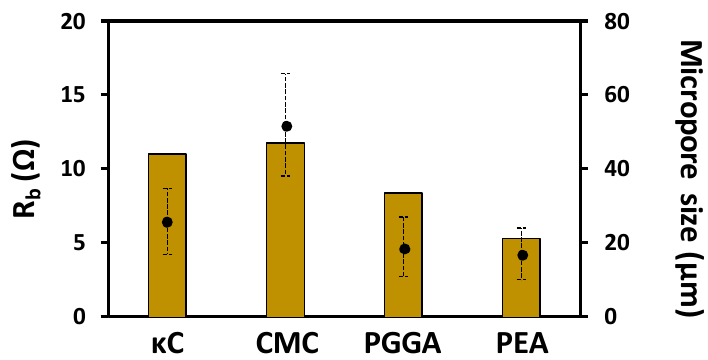
Figure 7. Relationship between pore size and the internal resistance for each of the hydrogel systems. The EEC used to fit the experimental EIS results for CMC, PGGA and PEA corresponds to the Randles-type electrical equivalent circuit [47]. In addition to R S and R P , the diagram shows two additional elements: (1) the capacitance C of the hydrogel in parallel with R P ; and (2) the constant phase element (CPE), which is associated with the capacitance of the electrical double layer (C dl ) on the electrode surface, in series with R P . In the case of κ C, the CPE is in parallel with resistance and, in addition, it shows a tangent hyperbolic diffusion element (T), also named bounded Warburg, which is common for porous